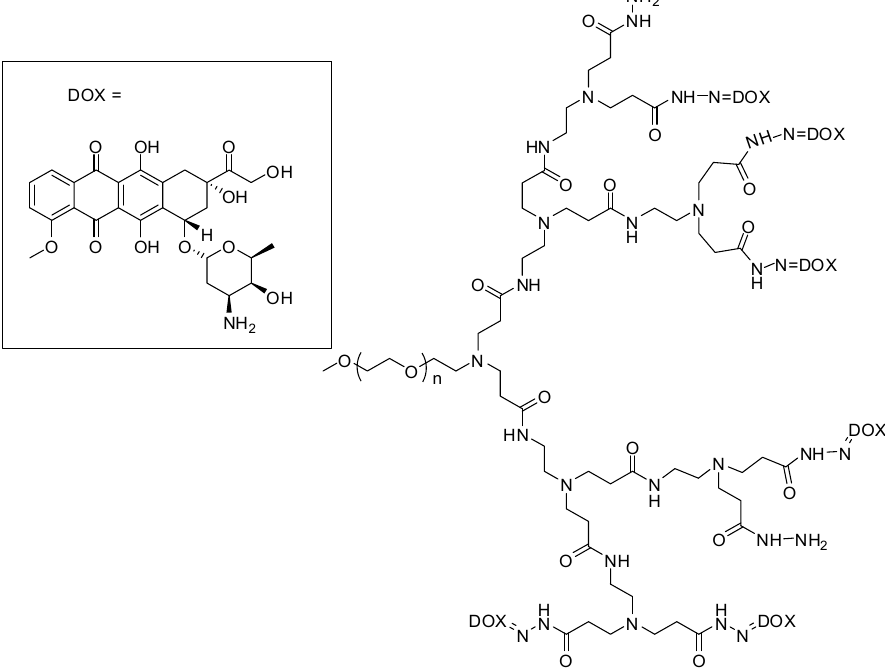
Figure 3. Doxorubicin PEGylated dendrimer prodrug [30].